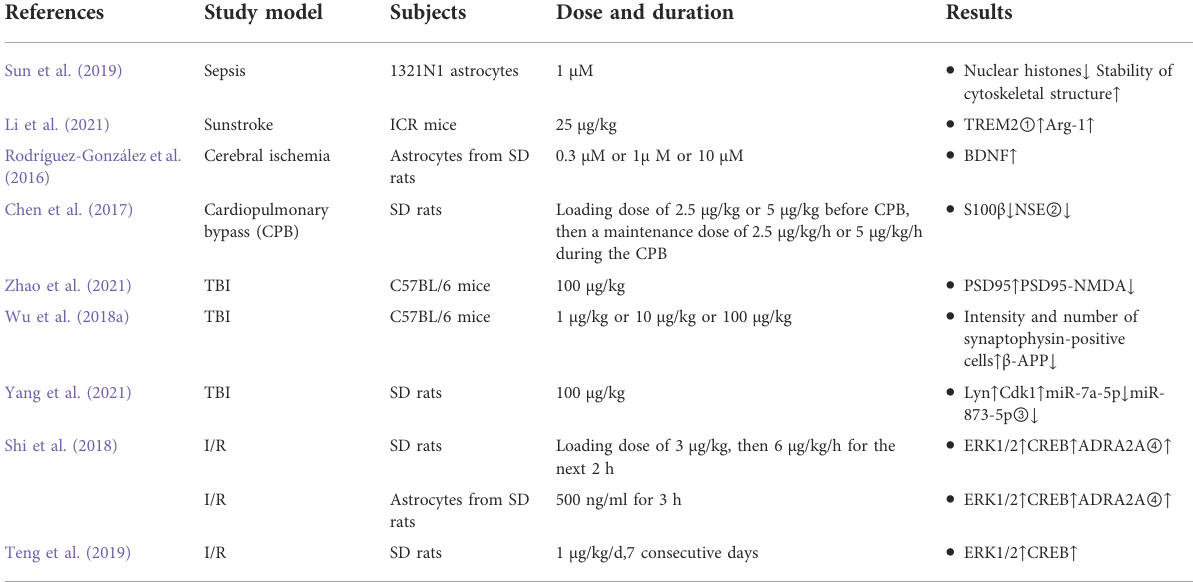
TABLE 5 Protective effect of DEX on the cell